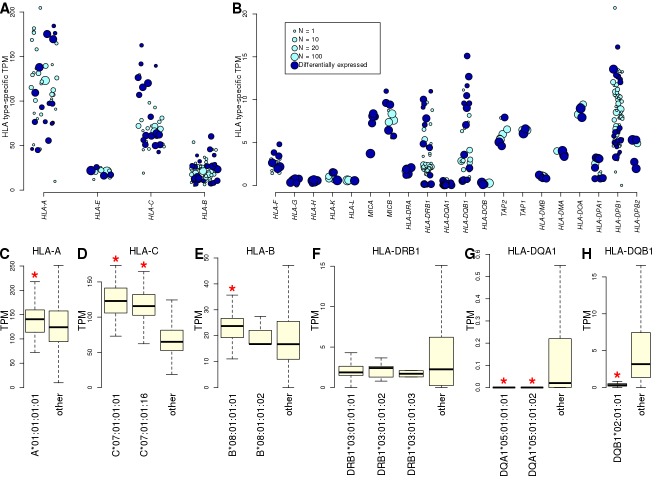
Allele-specific expression of HLA genes in iPSCs.(A, B) Mean TPM expression across HLA types: (A) shows the four HLA genes with highest expression levels (mean TPM >20); and (B) shows lower expressed HLA genes (mean TPM <20). Each point represents one allele. Point size represents the number of individuals carrying each allele. All HLA types are shown, although differential gene expression analysis (Supplementary file 5) was performed only on those present in at least two individuals. Eight-digit HLA-types significantly associated with the expression of their cognate HLA gene are shown in dark blue. (C–H) Boxplots showing mean expression of the eight-digit 8.1AH HLA types (Figure 1) compared with the mean expression of all the other HLA types for the cognate gene. Red stars indicate that the mean expression of the ancestral haplotype HLA type is significantly different (Supplementary file 5).